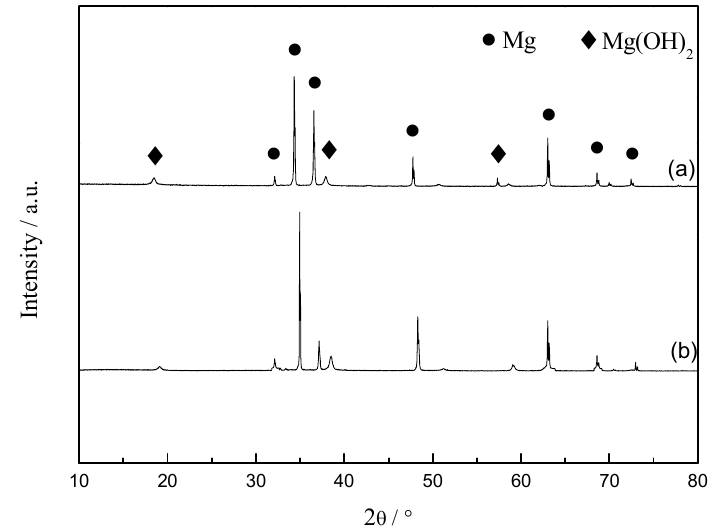
10 of 13 Figure 8. Surface scanning electron microscopy (SEM) images of typical samples: ( a ) CD: 2,000×; ( b ) CD: 10,000×; ( c ) CD + HT: 2,000×; ( d ) CD + HT: 10,000×. 3.6. Chemical Composition Figure 9 showed the XRD results for the typical Mg alloy samples. It’s obvious that the main phase composition of coatings was Mg(OH) 2 . Compared with the XRD pattern of the CD sample, that of the CD+HT sample did not show a new diffraction peak, which should be attributed to the trace